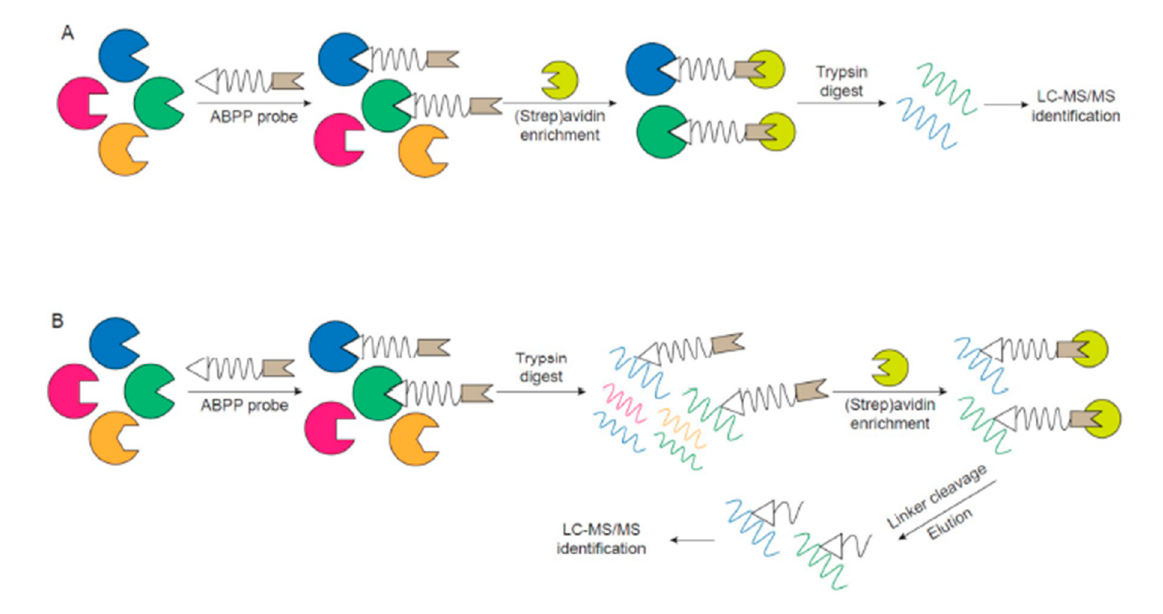
Figure 2. Example workflow of ABPP probe labeling followed by liquid chromatography-mass spectrometry / mass spectrometry (LC-MS / MS) analysis. ( A ) Representative scheme of ABPP probe labeling of samples proceeded by enrichment (i.e., avidin isolation of biotin-tagged probes), trypsinization and LC-MS / MS identification. ( B ) An alternative LC-MS / MS approach to directly identify the active site labeling by the ABPP probe using a cleavable linker sequence.